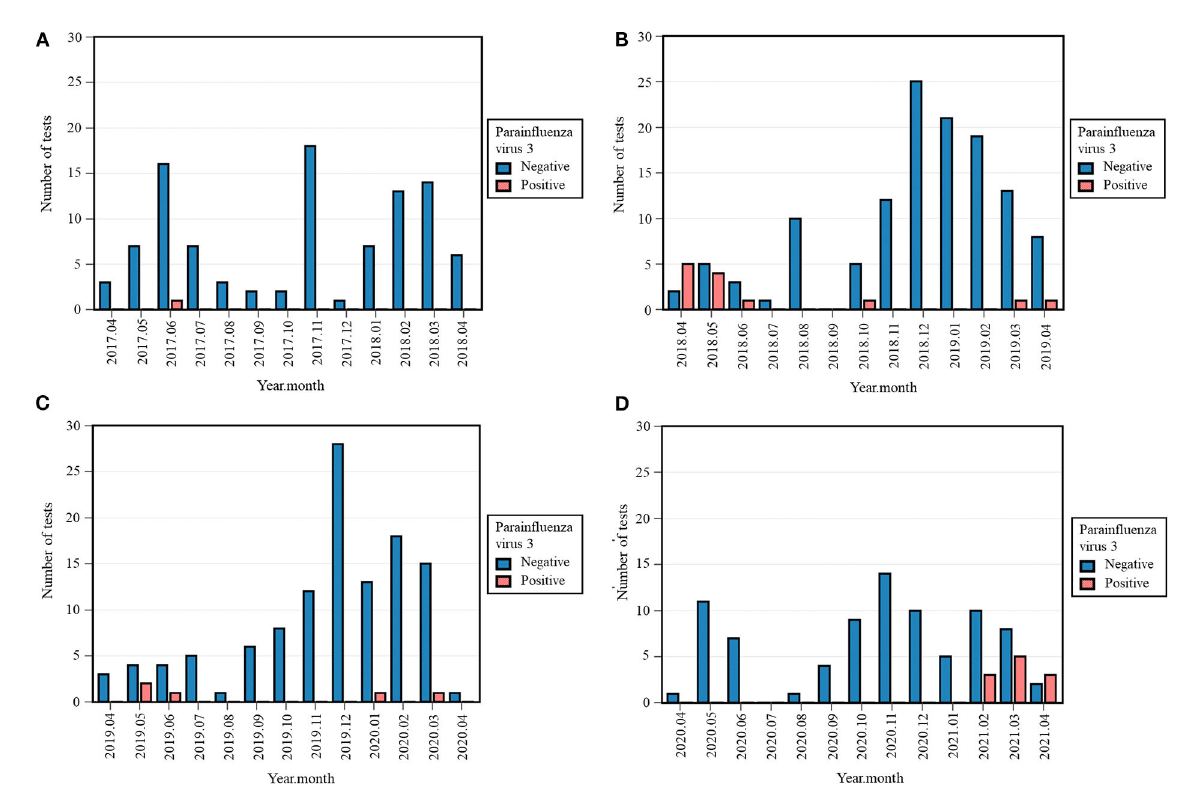
FIGURE4 Monthly occurrence of parainfluenza virus 3 (PIV-3) per year: 2017–2018 (A) , 2018-2019 (B) , 2019–2020 (C) , 2020-2021 (D) . Monthly occurrence was defined as the number of positive tests per month. Each 12-month period started on April 16th and ended on April 15th of the following year.